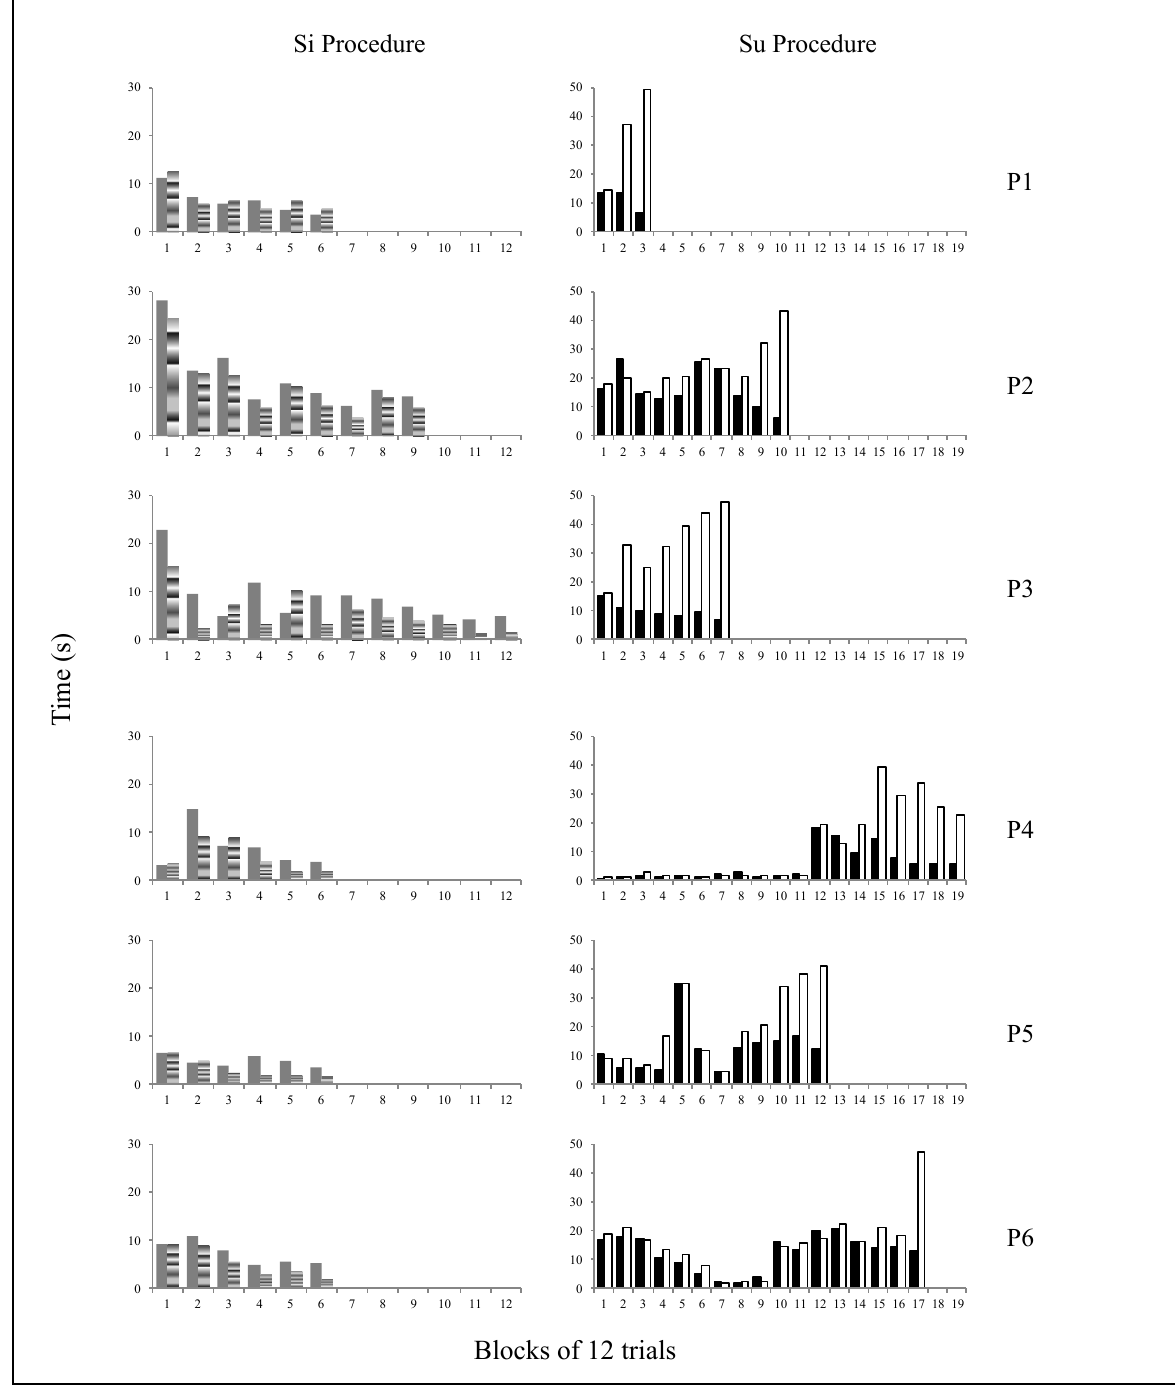
Figure 4. Time spent observing the set of stimuli in blocks of 12 trials in the Si and Su Procedures. The left portion presents results from the Si Procedure; gray bars represent the time spent observing the Set 1 stimuli (S+), and gray patterned bars represent the time spent observing the Set 2 stimuli (S–). The Su Procedure results are displayed on the right portion; black bars represent the time spent observing the Set 3 stimuli and white bars represent the time spent observing the Set 4